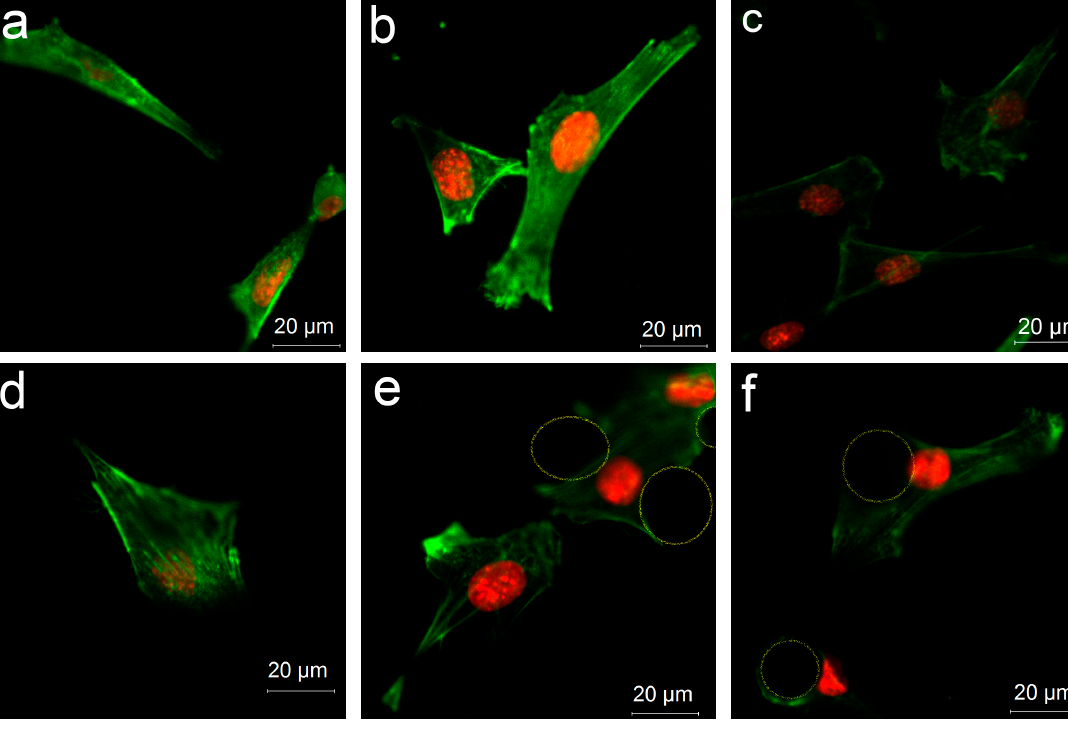
Figure 7. The confocal laser scanning microscopy (CLSM) images representing cellular distribution on different surfaces: ( a ) S, ( b ) B, ( c ) BS, ( d ) PS, ( e ) PB, ( f ) PBS. The circles identify the nanostructured microspheres.